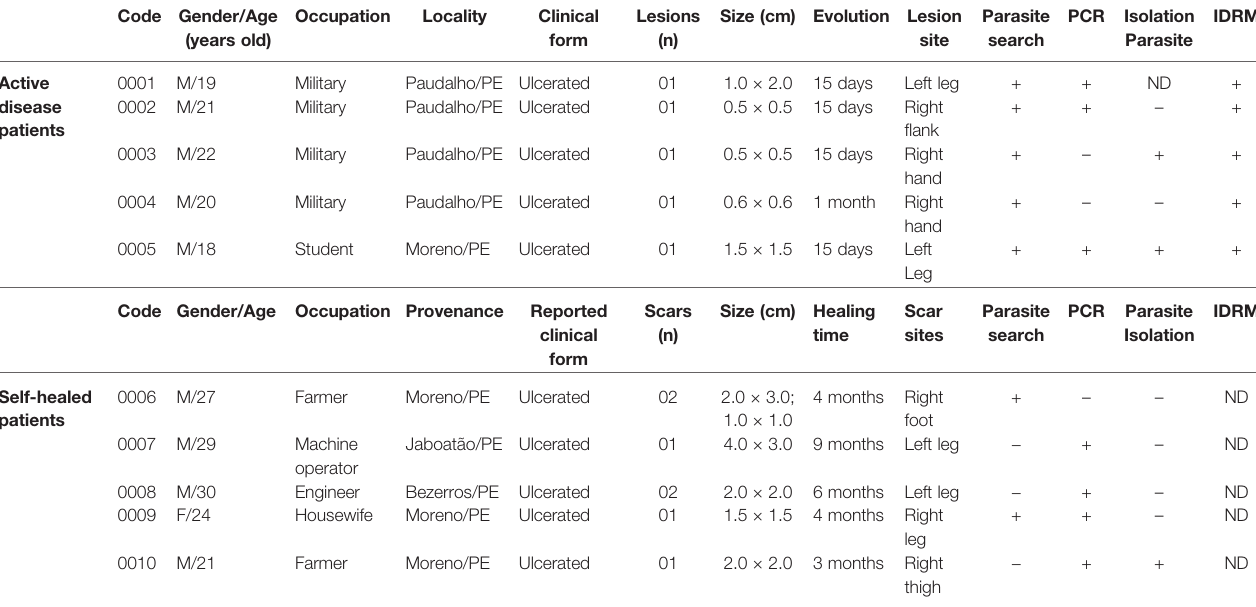
TABLE 1 | Demographic and clinical data of active disease and self-healed patients. Code Gender/Age Occupation (years old)